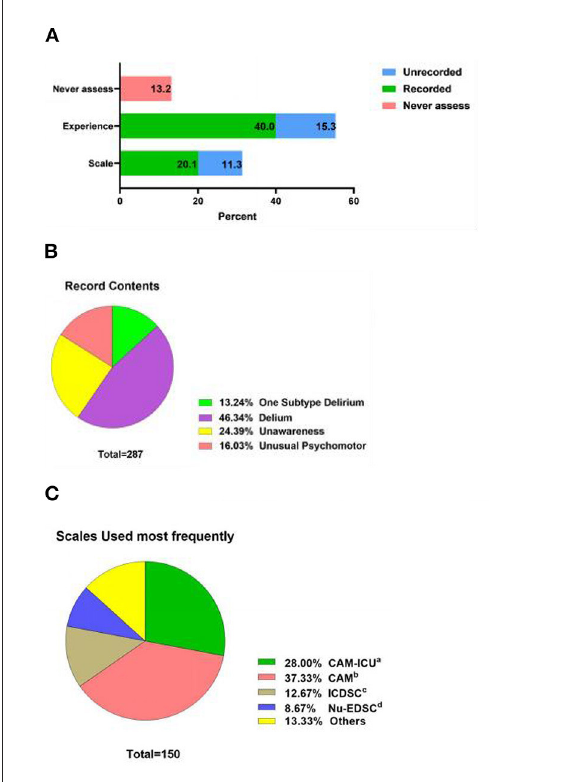
FIGURE5 (A) Record behaviors regarding delirium for clinical nurses ( n = 477). (B) Record contents regarding delirium for